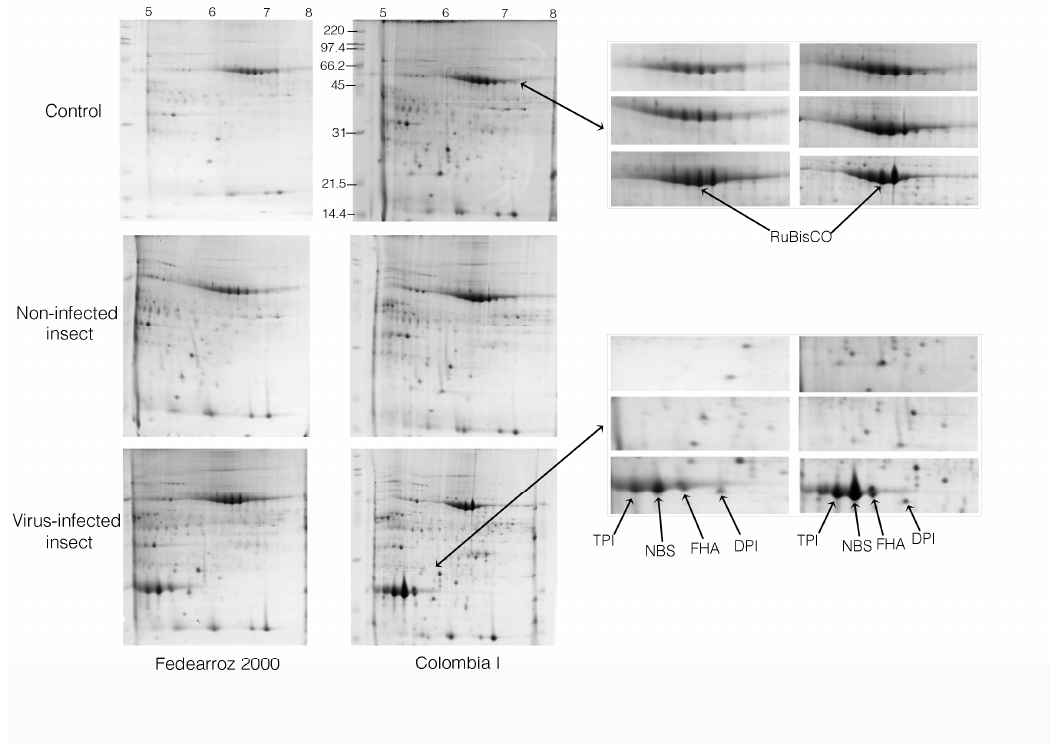
Figure 2. Gels obtained in the experiment contains spots for each treatment of the Fedearroz 2000 virus resistant commercial variety and Colombia I variety. Right panel shows a zoom of the regions indicated in the gels, and the organization follows the same pattern as the left panel. Images were created using the BioRad PDQUEST program, version 8.0.1. The spots indicated are RuBisCO: Ribulose-1,5-bisphosphate carboxylase/oxygenase; DPI: Adenosine diphosphate glucose pyrophosphatase; TPI: Triosephosphate isomerase; NBS: NBS-containing resistance-like protein containing protein; FHA: FHA domain containing protein DDL. Molecular weight ( y -axis) and pH ( x -axis) are indicated.